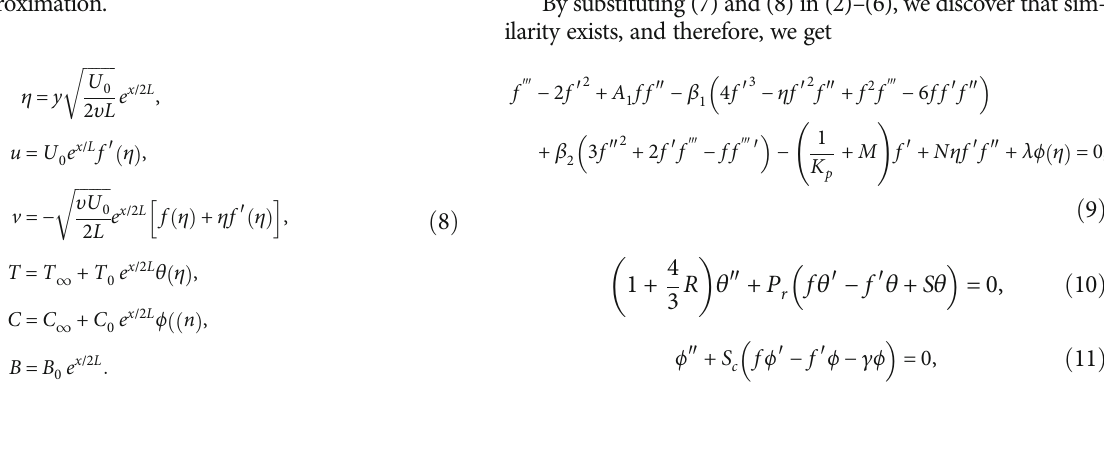
Figure 3: (a) Di ff erent values of permeability K (c) Di ff erent values of permeability K